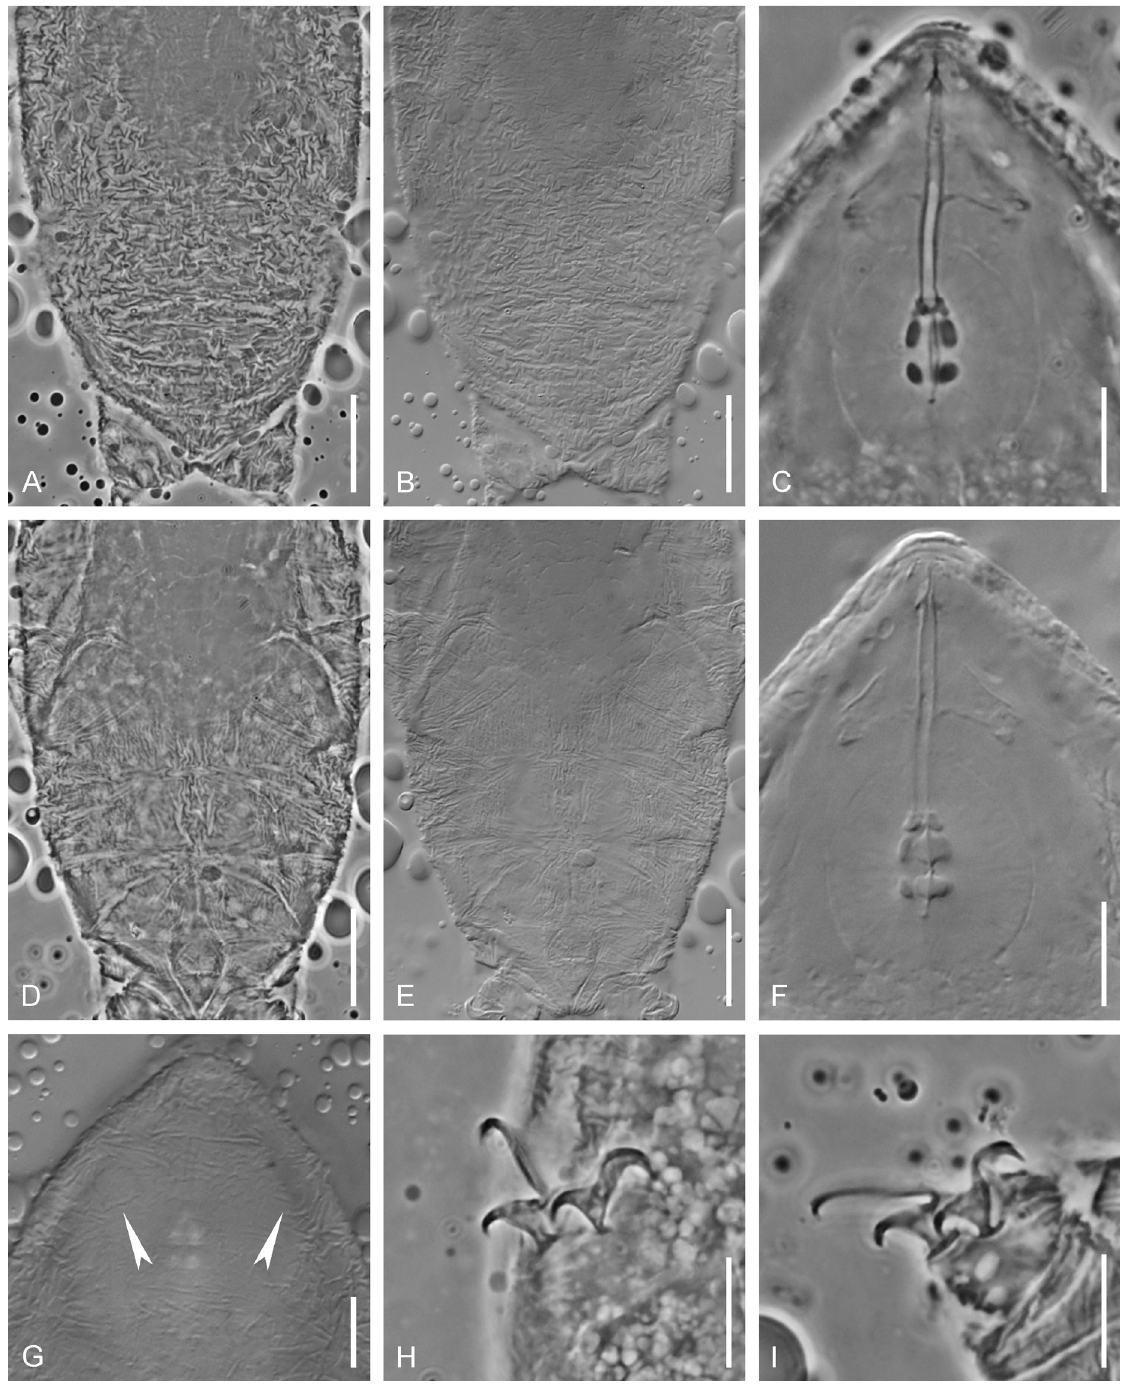
Fig. 9. Hypsibius scaber maucci, 1987, holotype (mCVR C.T. 12289) (A–G, I) and paratype (mCVR C.T. 12288) (H). A . Dorsal view of the caudal body end, PhC. B . Dorsal view of the caudal body end, DIC. C . Bucco-pharyngeal apparatus, PhC. D . Ventral view of the caudal body end, PhC. E . Ventral view of the caudal body end, DIC. F . Bucco-pharyngeal apparatus, DIC. G . Dorsal surface of the head region, white arrowheads indicate the presumable elliptical sensory organs, DIC. H . Claws of leg III, PhC. I . Claws of leg IV, PhC. Scale bars: A–B, D–E = 20 µm; C, F–I = 10 µm. Photo G presented by R. Guidetti, university of modena and Reggio Emilia,